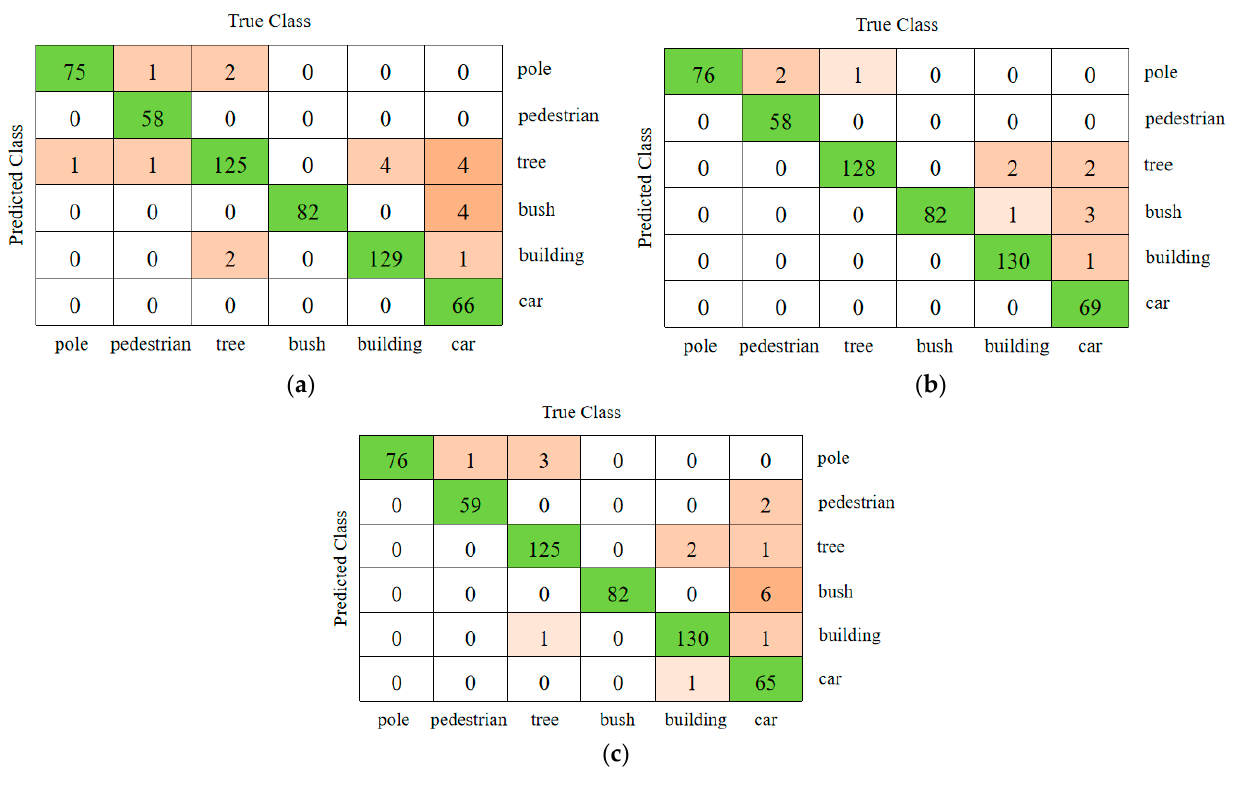
Figure 11. Classification confusion matrix for the experiments using 2D&3DHNet: ( a ) 20 × 20 × 20, ( b ) 25 × 25 × 25, ( c ) 30 × 30 × 30.